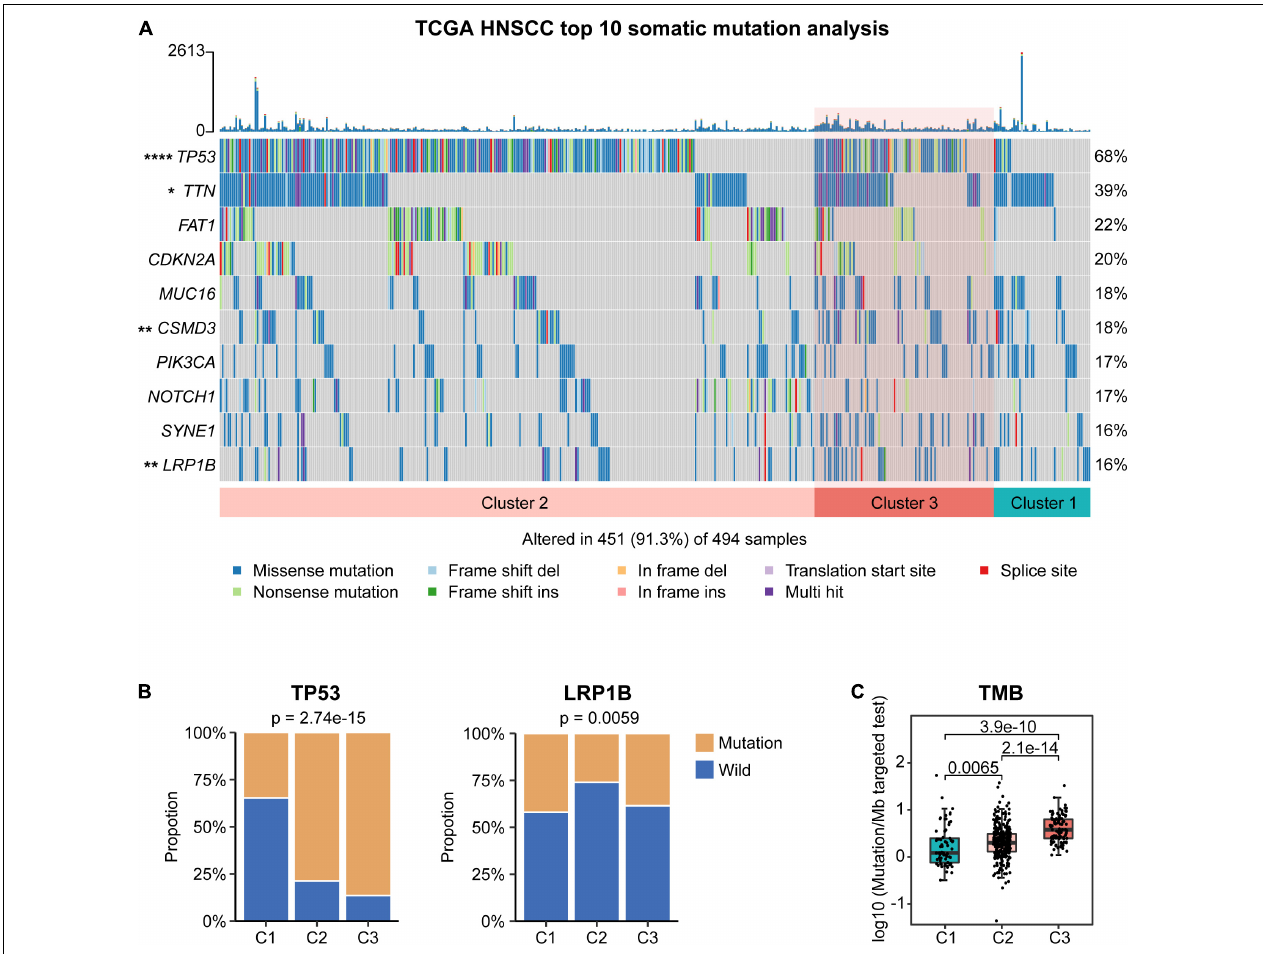
FIGURE 4 | Association between different molecular subtypes and tumor somatic mutation in The Cancer Genome Atlas (TCGA) cohort. (A) Top 10 highly mutated genes in head and neck squamous cell carcinoma (HNSCC) subtypes. (B) The proportion of TP53 and LRP1B mutation in different subtypes. (C) Tumor mutational burden (TMB) of different